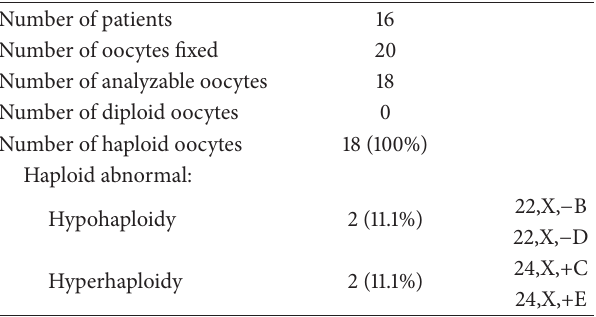
Table 2: A brief summary of our cytogenetic analysis of mono- pronuclear oocytes obtained after ICSI a